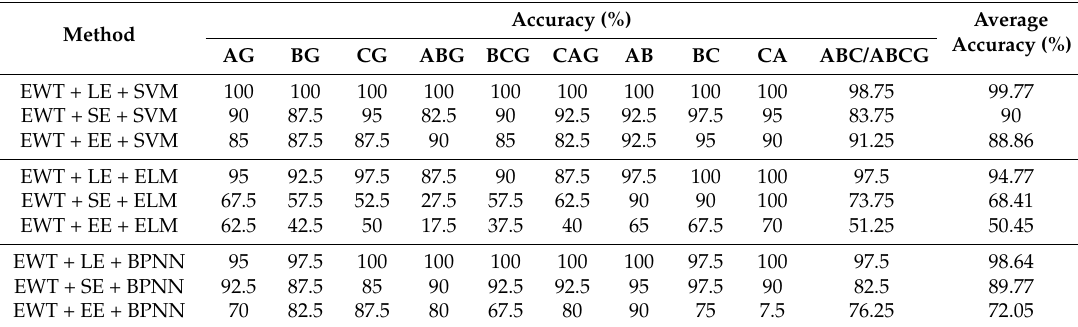
Table 6. Accuracy of different short-circuit faults classification